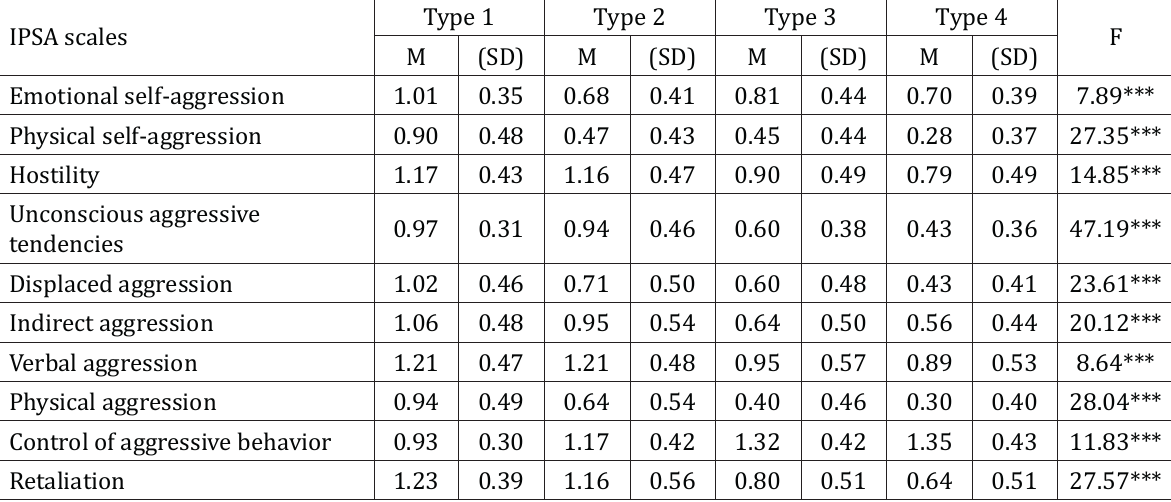
Table 3 shows the results of ANOVA and post hoc groups of adolescents on the scales of the Psychological Table 3. Mean scores obtained by the four groups (types) of gamers on IPSA scales Tukey’s test comparing the scores obtained by the four